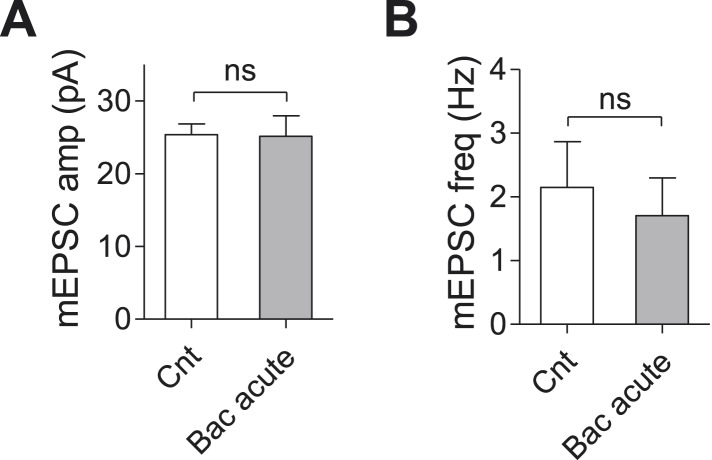
Baclofen does not affect mEPSC frequency and amplitude acutely.(A) mEPSC amplitude is not effected by acute application of baclofen (Cnt: 25.4 ± 1.5 pA, n = 31; acute Bac: 24.4 ± 2.9, n = 14, p = 0.72, unpaired, two-tailed Student's t-test). (B) mEPSC frequency is slightly, but not significantly, lowered by acute application of baclofen (Cnt: 2.1 ± 0.7 Hz, n = 31; acute Bac: 1.7 ± 0.6 Hz, n = 14, p = 0.7, unpaired, two-tailed Student's t-test).